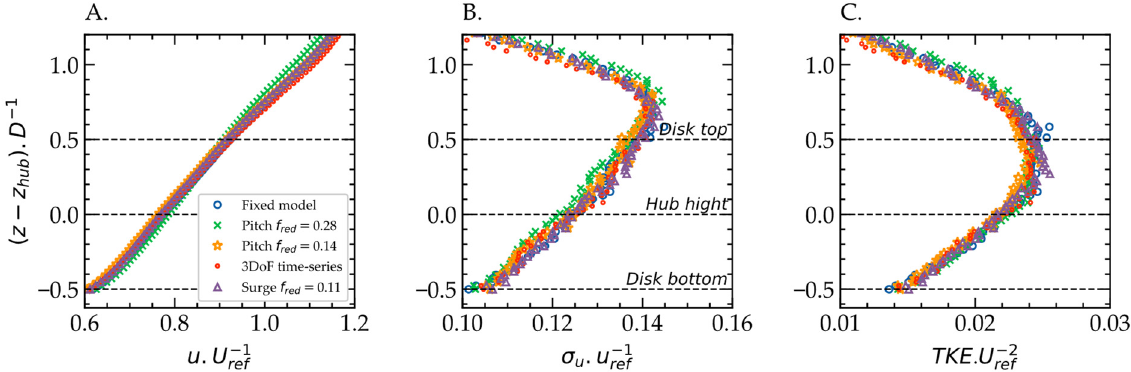
Figure 5. Statistics of the far-wake velocity field at turbine centreline ( Y = 0 ) versus the height; ( A ) Streamwise velocity; ( B ) Standard deviation of streamwise velocity; ( C ) Turbulence kinetic energy (TKE).